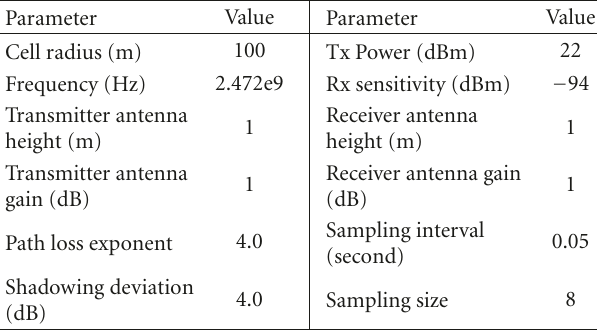
Table 5: Default parameters in a WLAN environment for the simulation of NDMD algorithm.